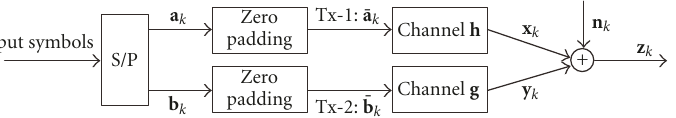
Figure 1: Two-branch transmit diversity with one